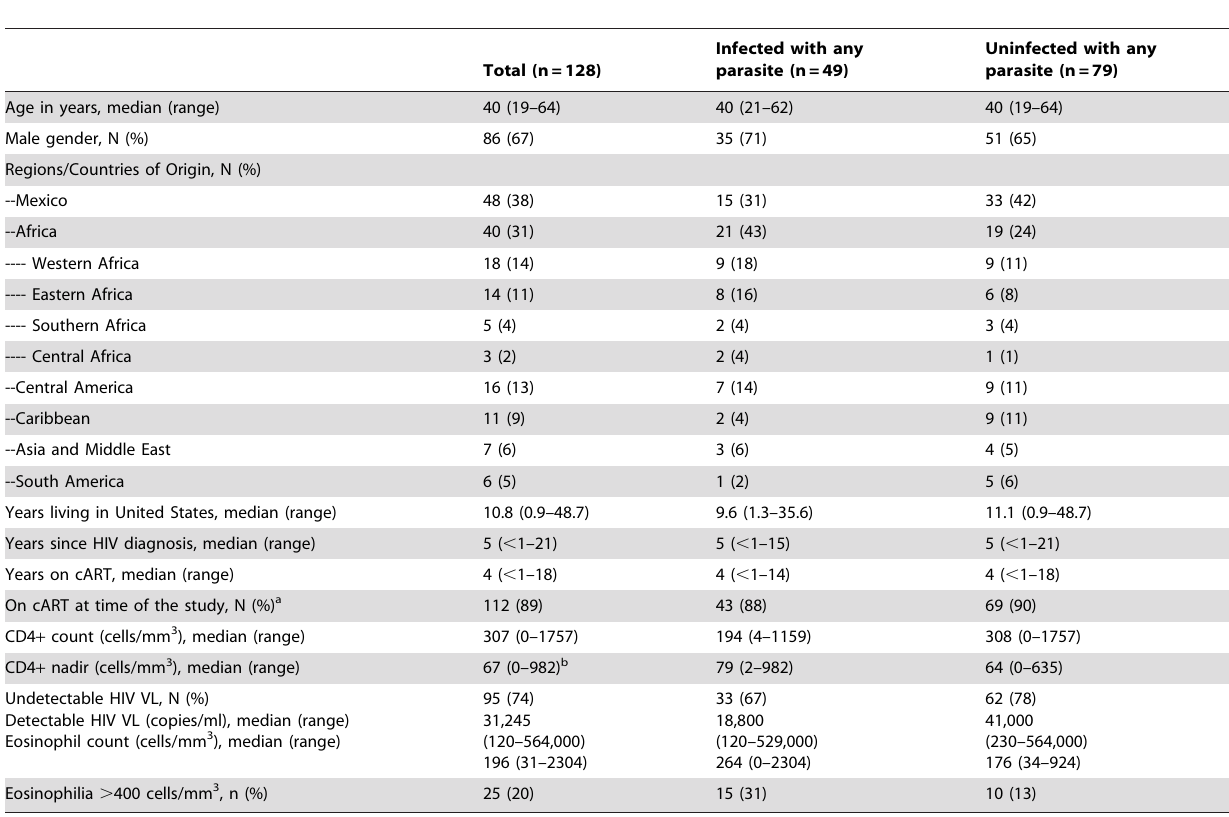
Table 1. Demographic and clinical characteristics of foreign-born, HIV-infected persons with and without parasite infections, 2009.